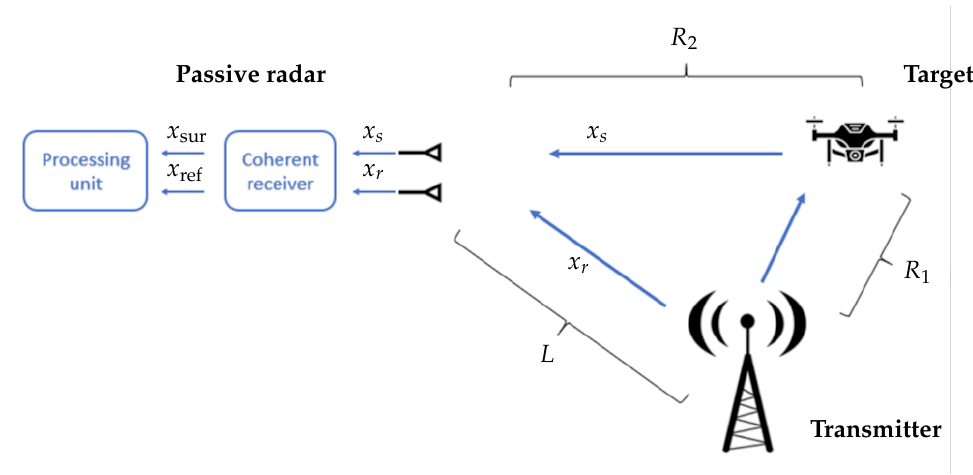
Figure 1. Typical PCL geometry.